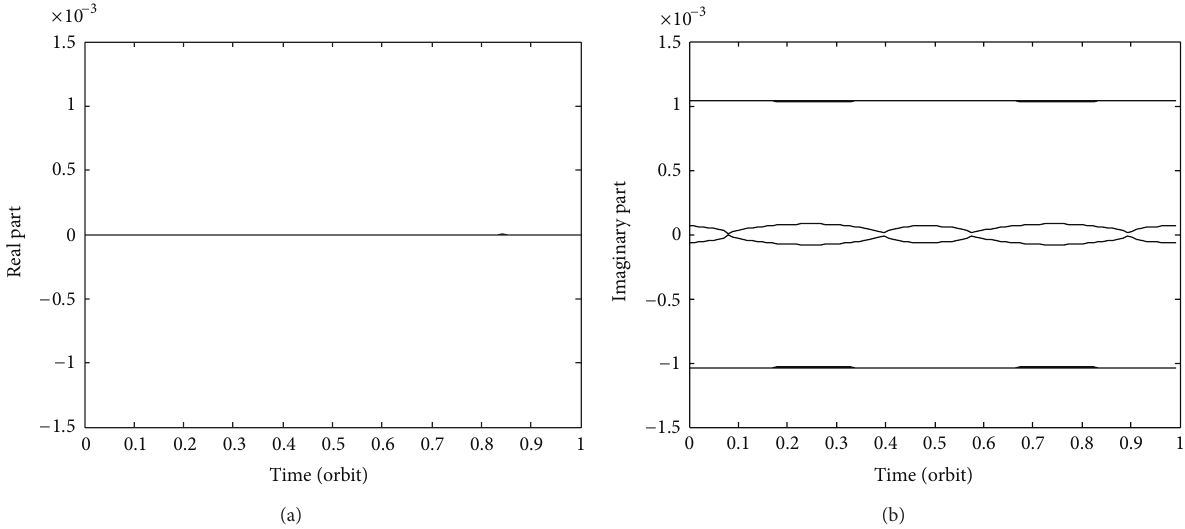
Figure 12: Topological type of the equilibrium in the controlled system: (a) the time history of real part of the equilibrium during the orbital period; (b) the time history of imaginary part of the equilibrium during the orbital period; on the mean circular orbit with 𝑎 = 7178.137 km , 𝑖 = 80 ∘ , and an initial argument of latitude of 0 ∘ .